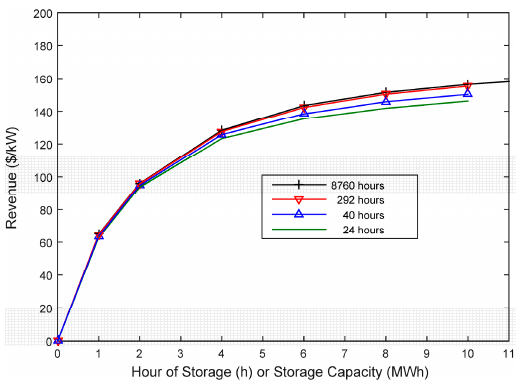
Figure 13. Potential annual arbitrage revenue (1 MW, 95% round trip efficiency) vs. energy/power ratio for a particular node for different periods of perfect forecast optimization.